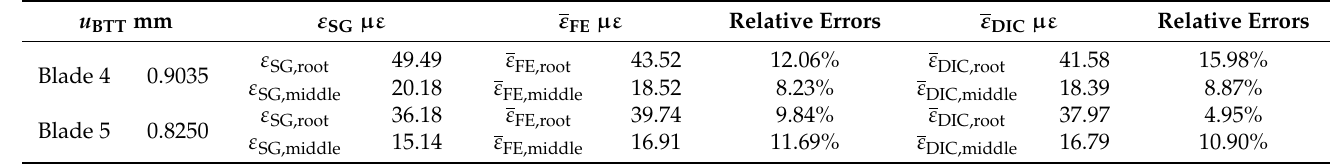
Table 4. Dynamic strains from SG and predicting model in blade synchronous vibration of 4